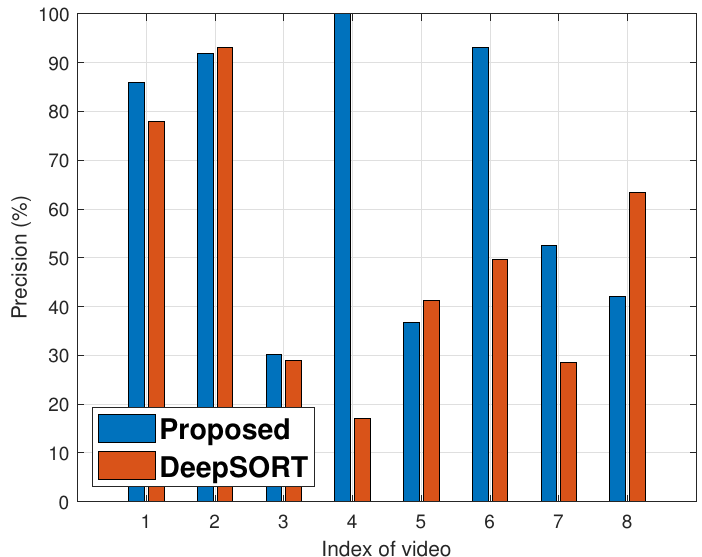
Figure 10. The average tracking precision of object tracking.